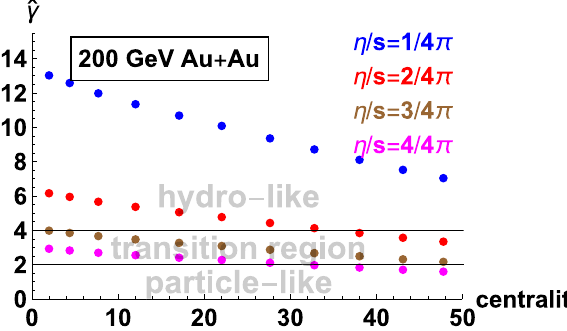
Fig. 7 SameasFig.6,butforAu+AucollisionsatRHICwheresmaller dE ⊥ values lead to reduced ˆ γ values in the same centrality bin d η s